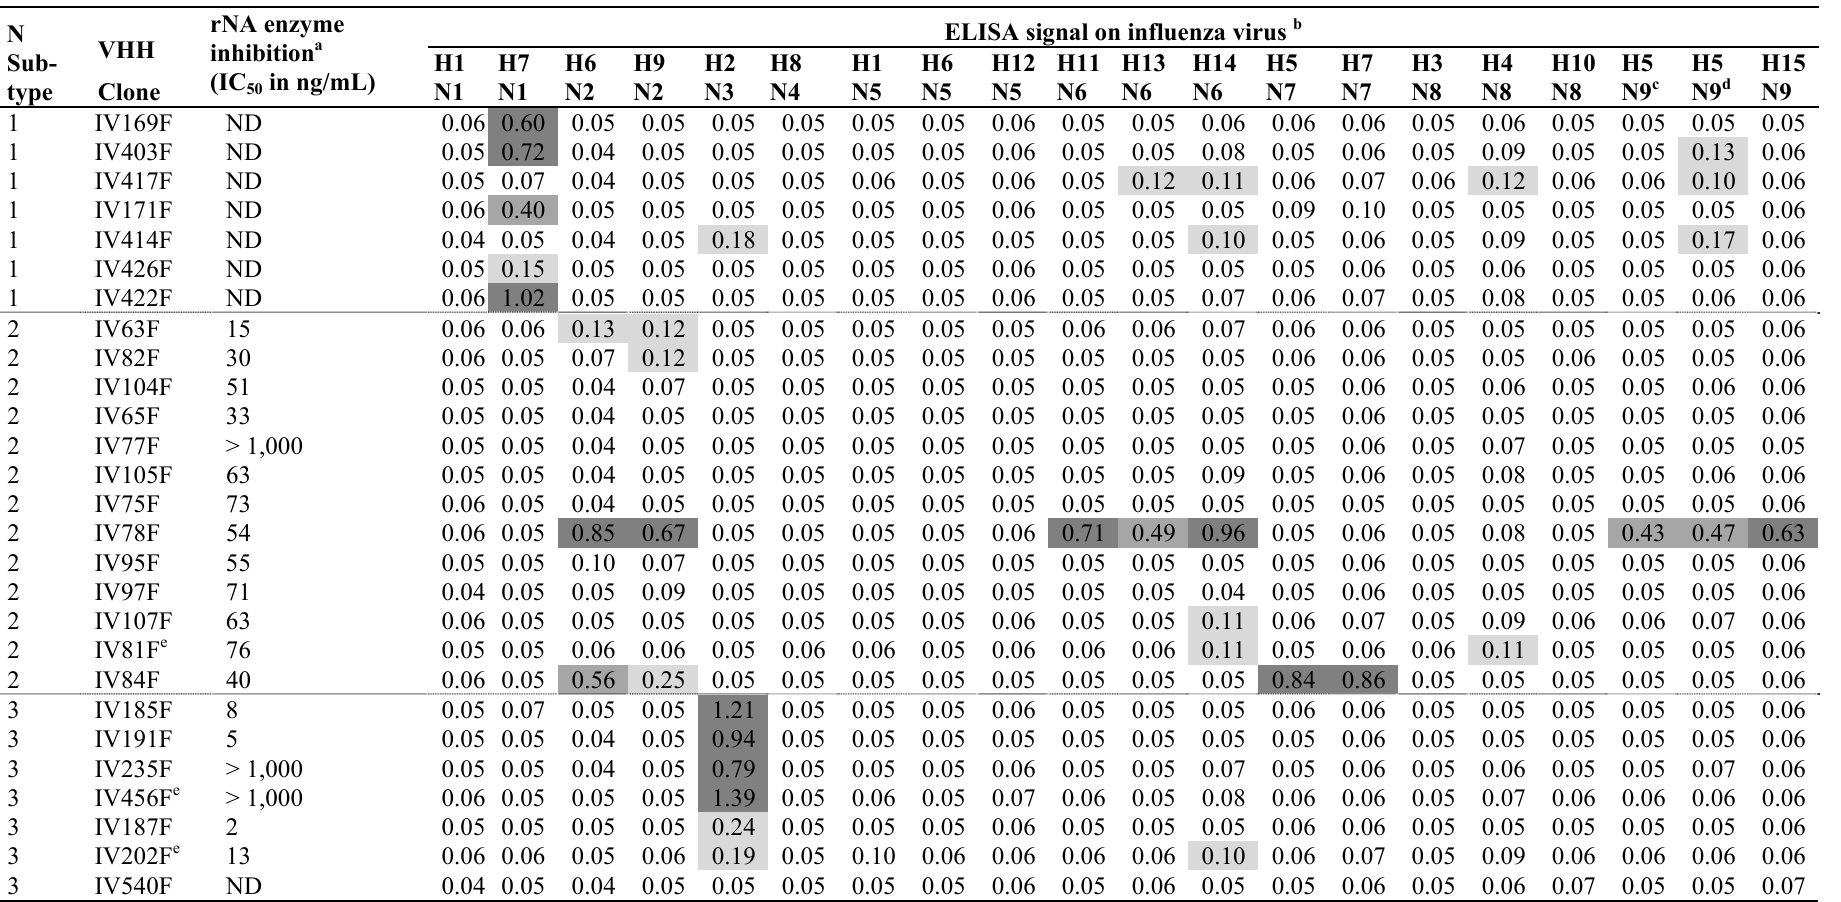
Table 5. Inhibition of rNA activity and binding in ELISA to influenza viruses of different subtypes of 64 yeast-produced VHHs.